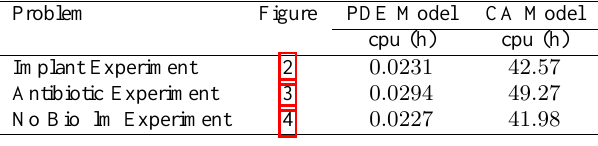
PDE Model CA Model